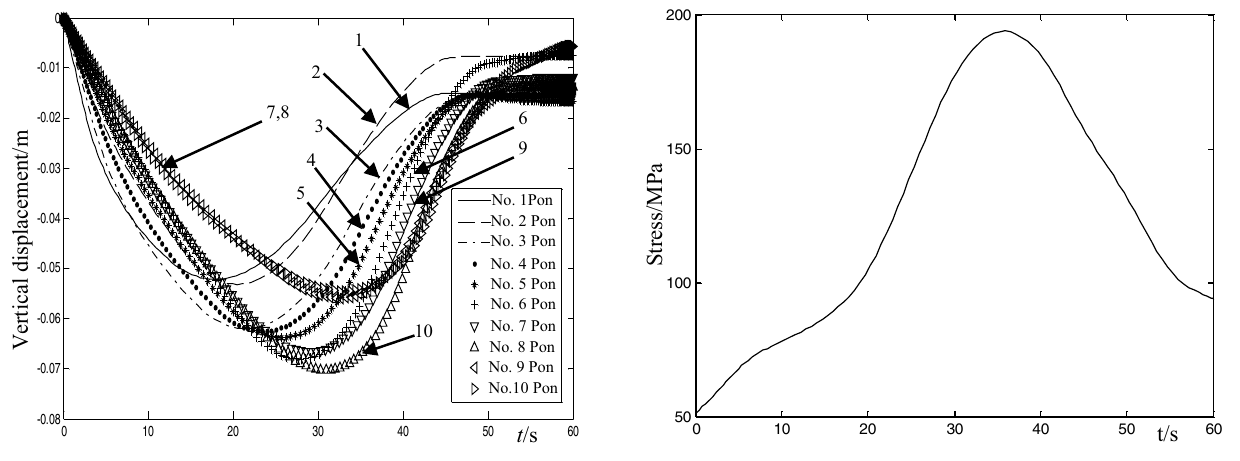
Fig. 15 Time history of maximum stress in the bridge girder